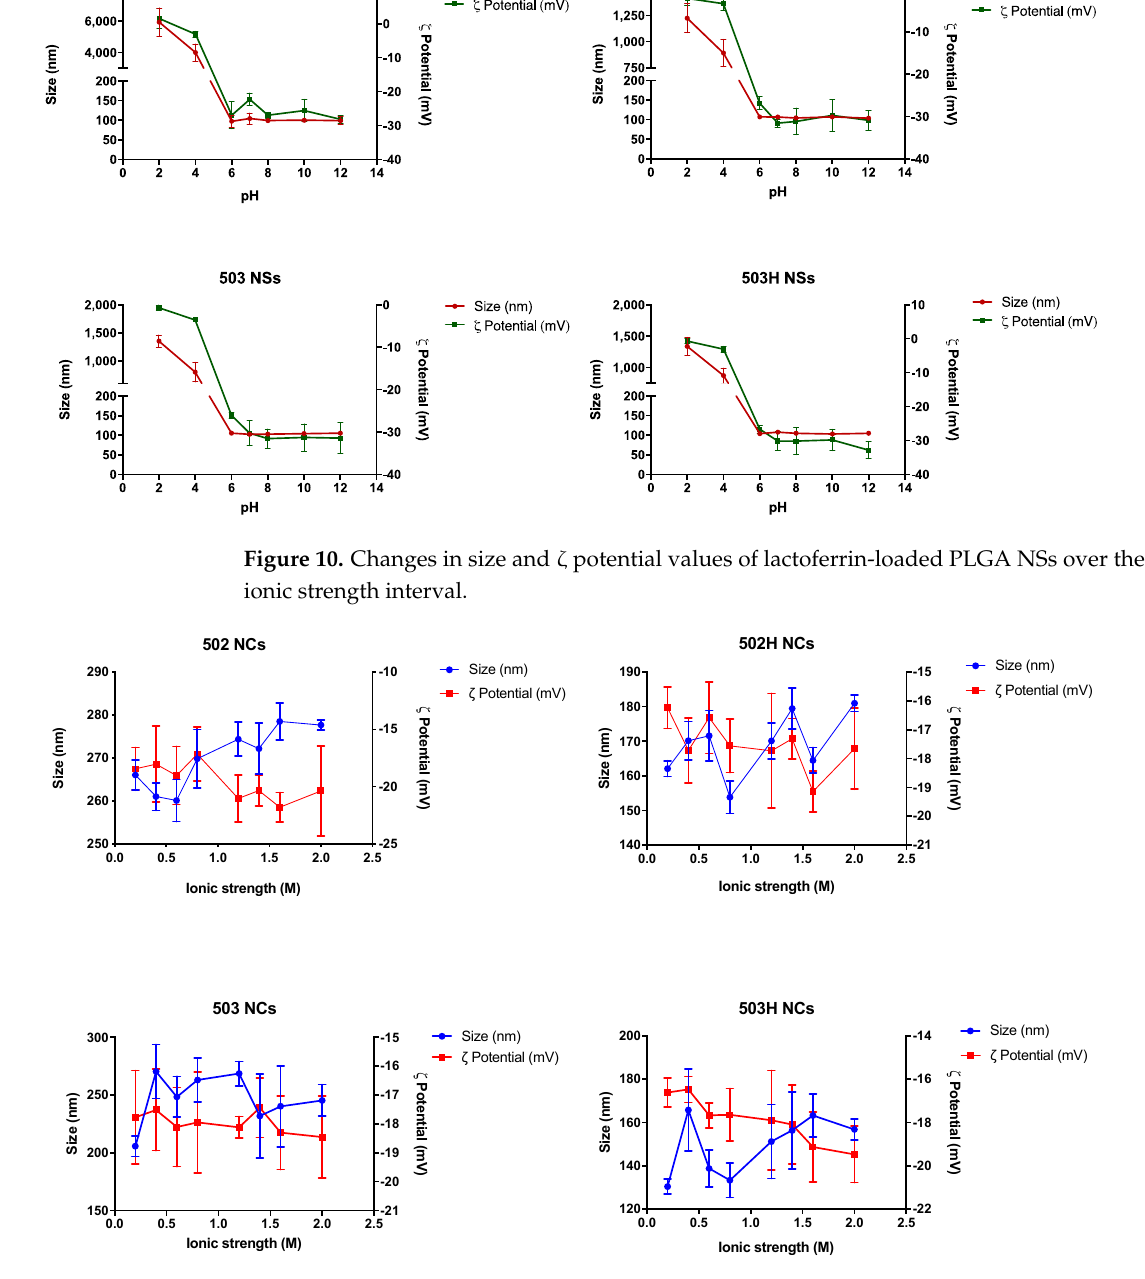
Figure 11. Changes in size and ζ potential values of lactoferrin-loaded PLGA NCs over the studied ionic strength interval.